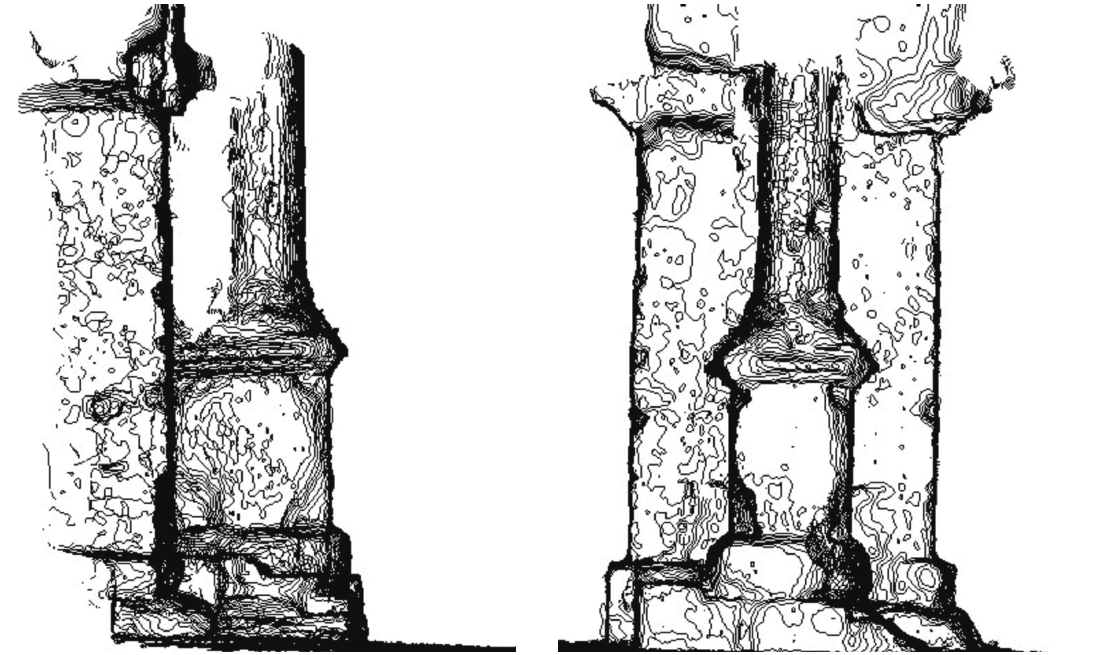
Figure 10. Plinth and base of left column on Southern façade. Front and Western side of survey model